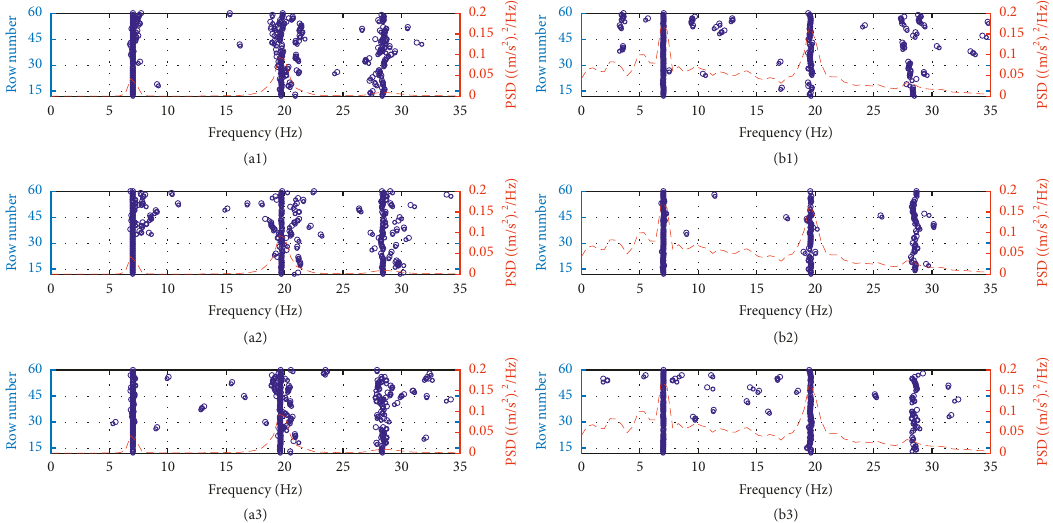
Figure 6: Stabilization diagram of CoS-SSI. (a1) CoS-SSI (SNR SSI (SNR